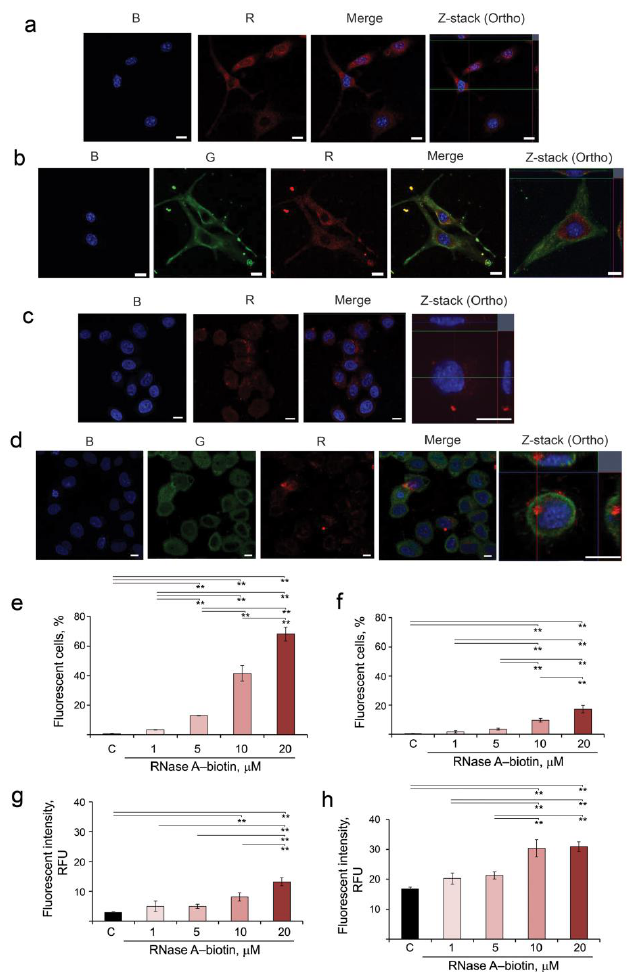
Figure 1. Accumulation of RNase A in B16 and HeLa cells, its intracellular localization and co-localization with RI. ( a,b ) B16 cells. ( c,d ) HeLa cells. B16 and HeLa cells were incubated in the presence of RNase A–biotin conjugate (20 µM) for 4 h followed by staining with streptavidin-APC, anti-RI rabbit antibodies and goat anti-rabbit antibodies conjugated with Alexa Fluor 488 and analyzed using confocal microscopy. Fluorescence in the blue channel (B panel) corresponds to NucBlu (nuclei staining), the green channel (G panel) corresponds to RI stained by Alexa Fluor 488 and the red channel (R panel) corresponds to RNase A–biotin conjugate stained with streptavidin- APC. Scale bars: 10 µ m. ( e , g ) Accumulation of RNase A in B16 cells. ( f , h ) Accumulation of RNase A in HeLa cells. B16 and HeLa cells were incubated with the RNase A–biotin conjugate at concentrations of 1, 5, 10 and 20 µ M at 37 ◦ C for 4 h and analyzed using flow cytometry. Data were statistically analyzed using one-way ANOVA with a post hoc Tukey test and are presented as mean ± S.E.M.; ** p <